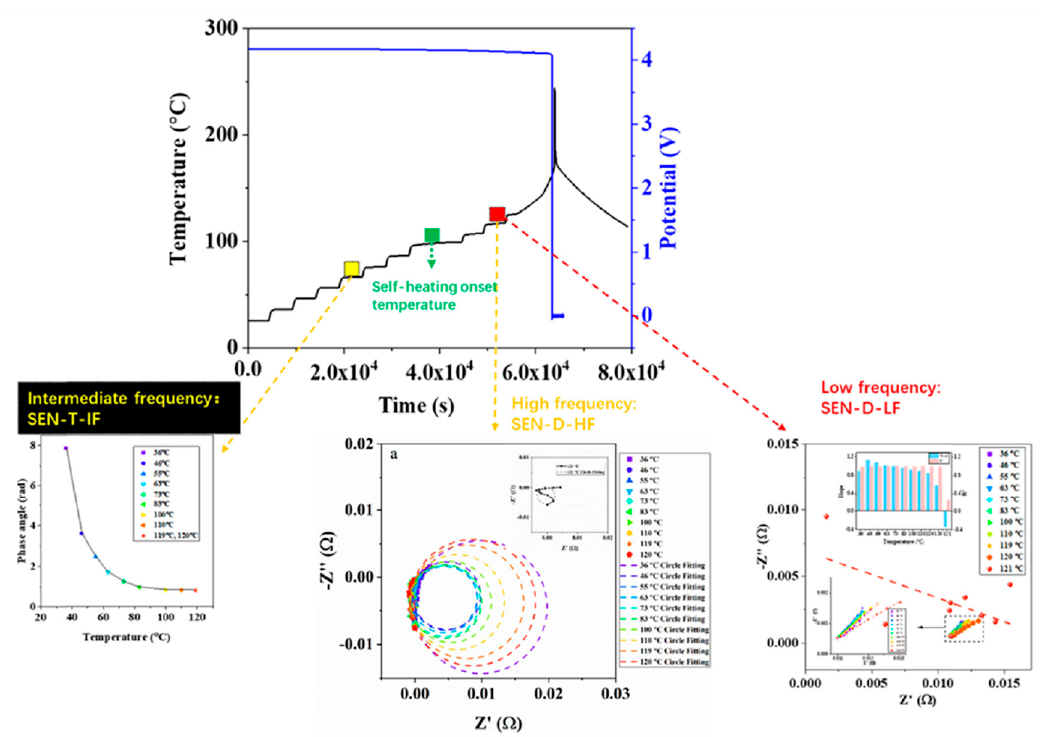
Figure 7. The EIS-derived indicators in the intermediate-frequency, low-frequency, and high-frequency are used to give reliable and early warnings of TR [94].